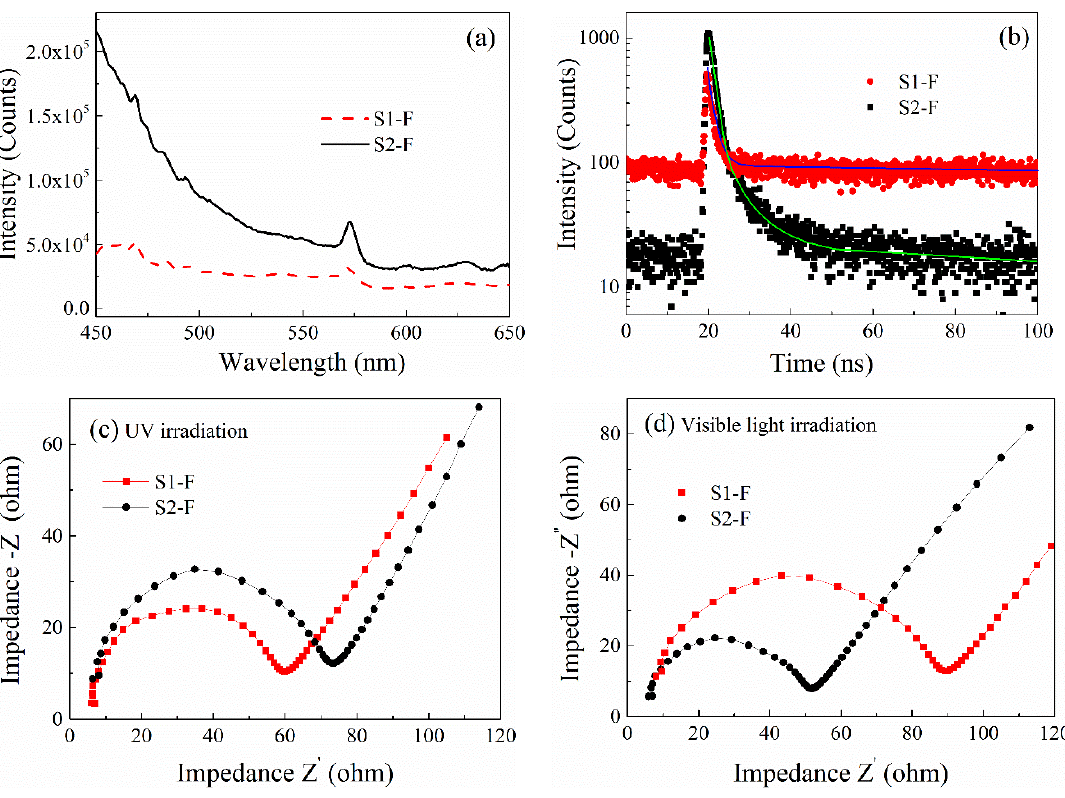
Figure 3. ( a ) Steady-state photoluminescence (PL) spectra and ( b ) time-resolved PL spectra with excitation at 340 nm and monitoring at 460 nm; electrochemical impedance spectroscopy (EIS) Nyquist plots under ( c ) UV and ( d ) visible light irradiation of the as-modified PET filaments. The time-resolved PL spectra for the resultant PET filaments obtained from both schemes are fitted by using biexponential kinetics, in which two decay components are obtained. The decay time